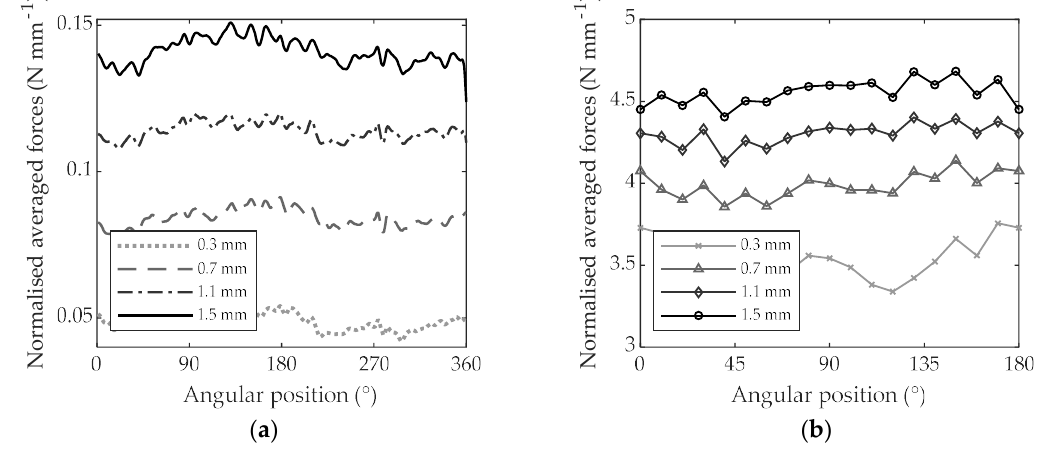
Figure 9. Cutting forces machining with different depths of cut (0.3, 0.7, 1.1 and 1.5 mm): ( a ) average force per revolution for every degree of angular position ( Fc ); ( b ) average cutting force referring to the cutting period reported every 10 ◦ of angular position ( F C ).